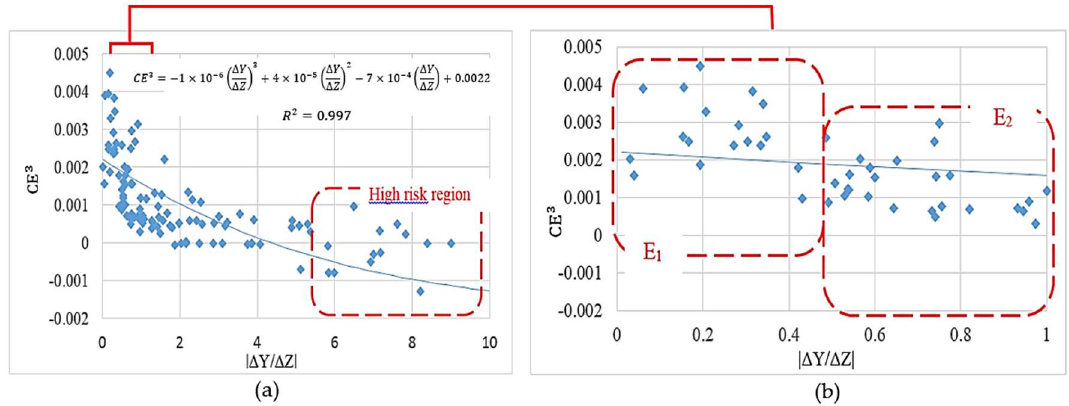
Figure 10. The effect of scaffold design on the cartilage cell culture efficiency, ( a ) full simulation results; ( b ) simulation results in a range of |ΔY/ΔZ| ∈ [0–1]. Table 2. Overview of the simulation exploratory workspace for an improved scaffold design. Figure Case Case Configuration Diameters Result Reference Biomass present on surface of all four fibers